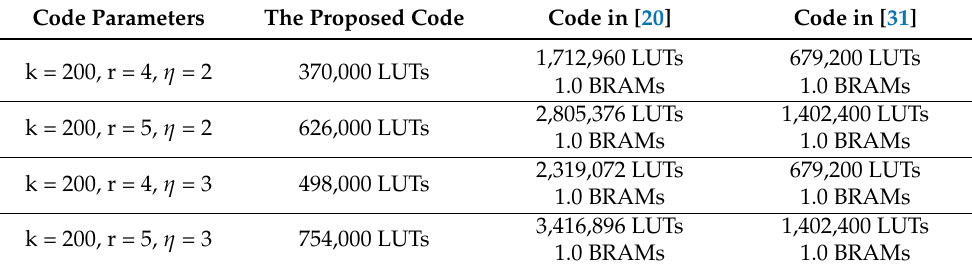
Table 2. LUTs used in the decoder hardware